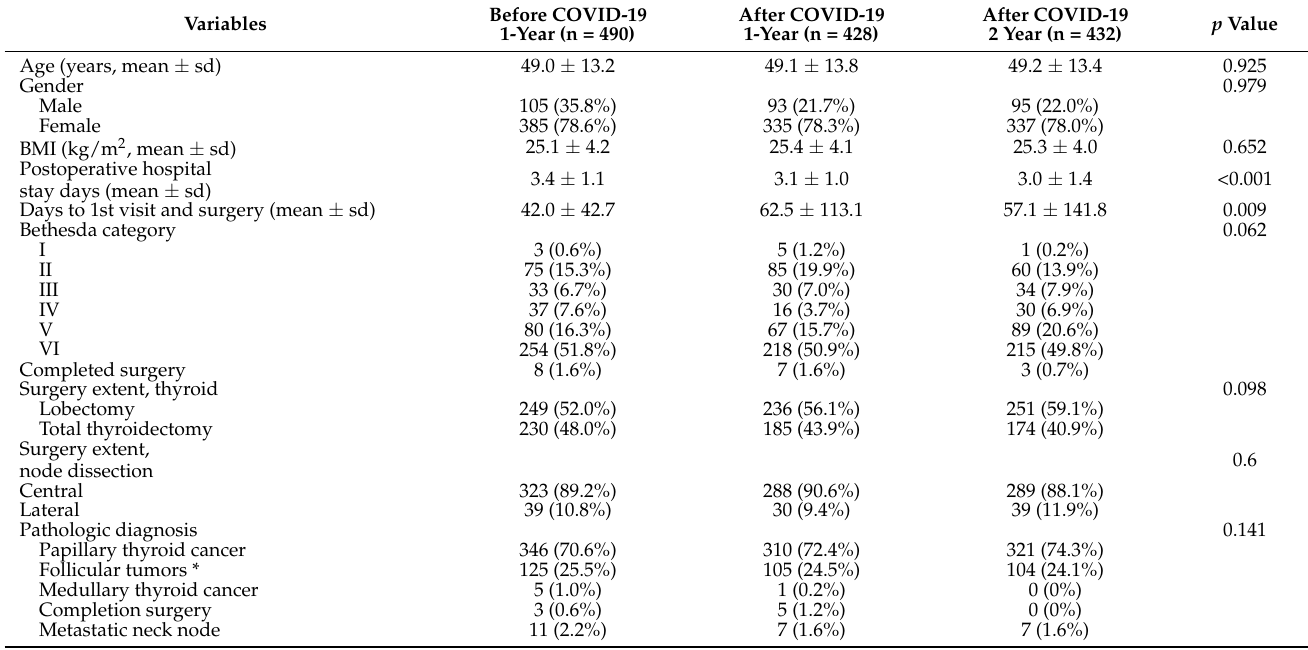
Table 1. Clinical characteristics of patients.